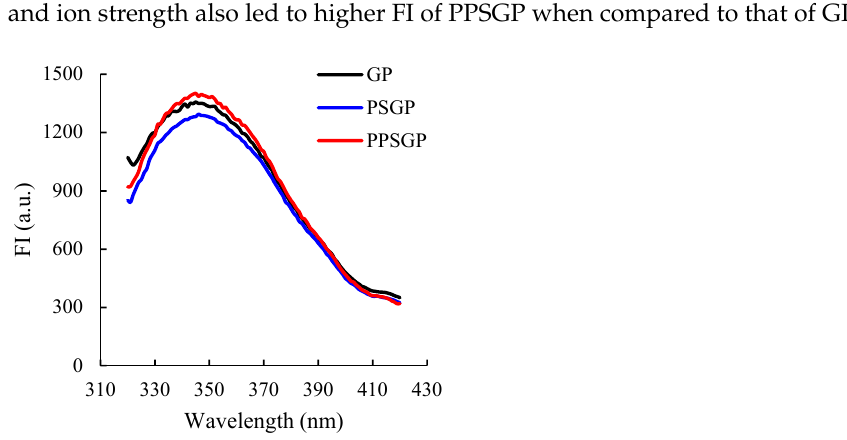
8 of 16 Figure 2. Fluorescence spectroscopy of GP isolate for surface hydrophobicity and an index of protein hydrophobicity (S 0 ). ( A ) represented surface hydrophobicity; ( B ) represented S 0 . Different letters indicate significant differences. 3.3. Intrinsic Fluorescence The intrinsic fluorescence spectrum was generally used to characterize the changes in tertiary structure of proteins due to the sensitivity of intrinsic fluorescence of aromatic amino acid residues to the polarity of microenvironments [33,42]. It is mainly attributable to Trp. Thus, fluorescence spectroscopic analysis is suitable for the evaluation of changes in the tertiary structure of GPI. As shown in Figure 3, the maximum emission wavelength ( λ max) values of GP, PSGP, and PPSGP were 345, 346, and 345 nm, respectively. Com- pared with the FI of GP, that of PSGP remarkably decreased. The double pH shifting pro- cess altered the compact structure of goose liver proteins, thereby changing the extent of